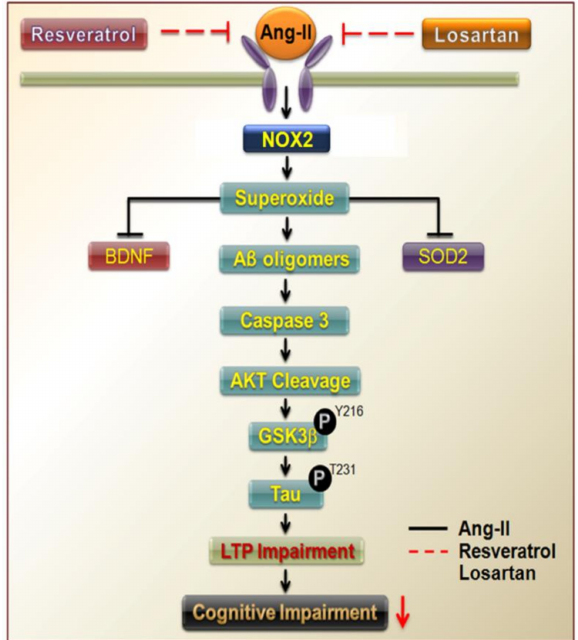
Figure 5. Resveratrol attenuated ROS-induced cognitive impairments in rats with Ang-II-induced early AD. Ang-II not only increased the generation of superoxide and the activity of the A β –caspase 3–Akt–GSK-3 β –Tau pathway by positively regulating NOX2 levels, but also attenuated SOD2